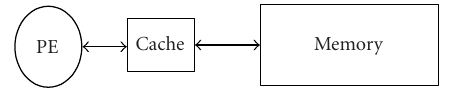
Figure 3: Cache-memory FFT processor architecture